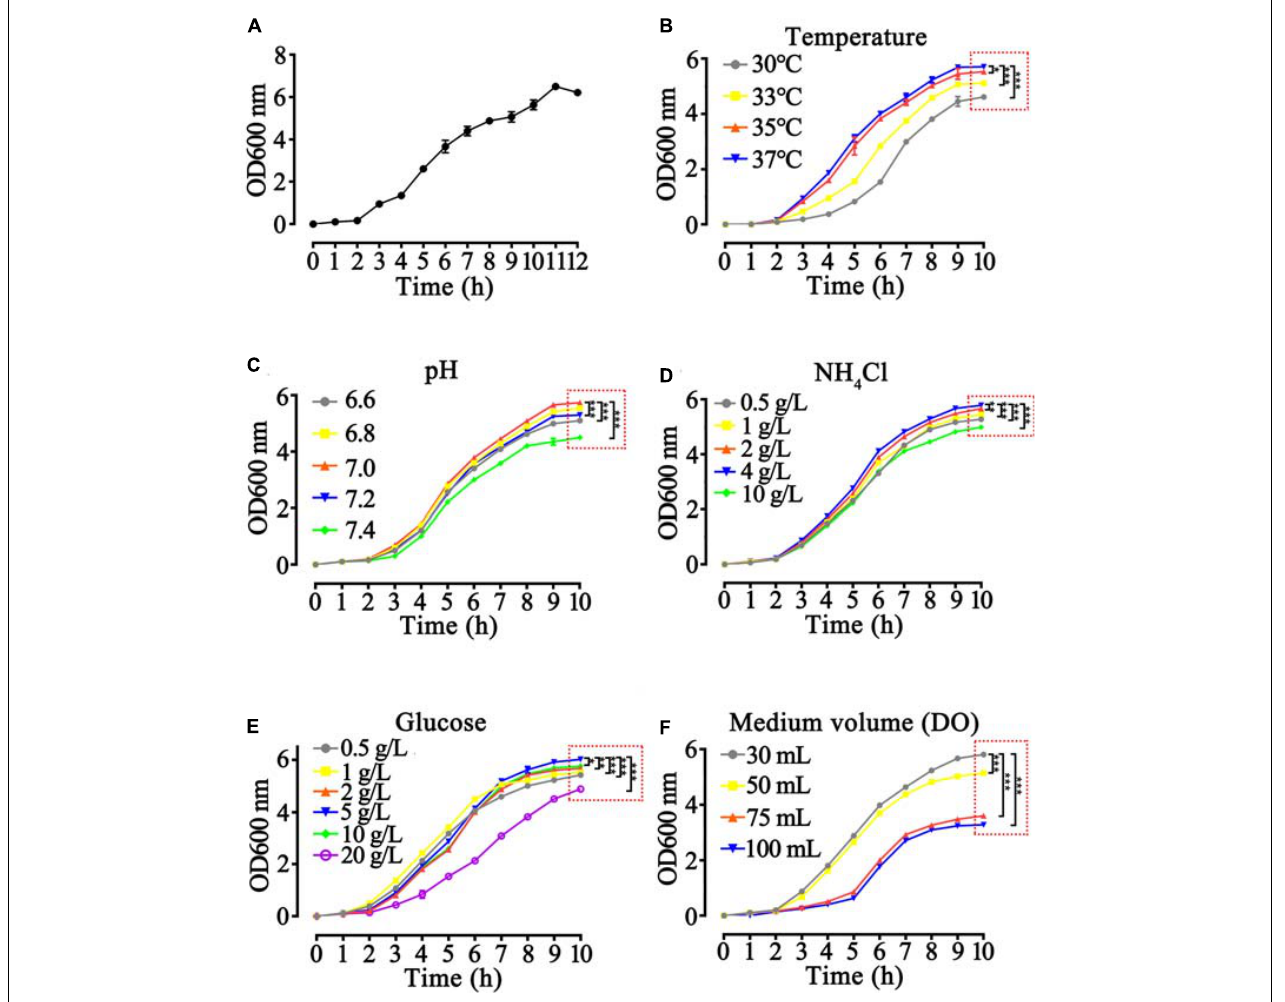
FIGURE 2 | Optimization of growth parameters of rhaFGF 135 E. coli strain in 30 mL LB medium. (A) The 12-hgrowth curve of the rhaFGF 135 E. coli strain in 30 mL LB medium at 37 ◦ C, 200 rpm. (B–F) The 10-h growth curve of rhaFGF 135 E. coli strain under different conditions, including (B) temperature of 30, 33, 35, and 37 ◦ C, (C) pH in the range of 6.6–7.4, (D) NH 4 Cl concentrations in the range of 0.5–10 g/L, (E) glucose concentrations in the range of 0.5–20 g/L, and (F) medium volume (30, 50, 75, and 100 mL). All experiments were performed in 250 mL shake flask. Asterisks indicate significant difference (* p < 0.05, ** p < 0.01, *** p < 0.001, n =